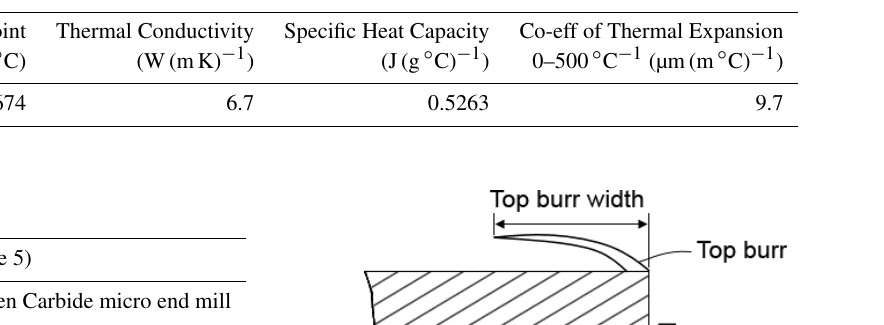
Table 3. Physical properties of Ti-6Al-4V.